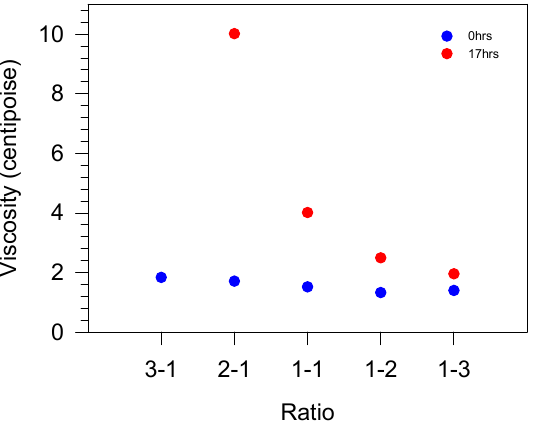
Figure 5. Change in viscosity with increasing TG:ST ratio and crosslinking time. Pot-life was tested for the TGST system to compare with the low-alcohol LA(TGST) system to determine if the removal of alcohols from the TG and ST precursor solutions impacted the LA(TGST) formulation stability with increasing crosslinking time t . All solutions of TGST and LA(TGST) were clear solutions at t = 0 h but became progressively cloudy on standing overnight at t = 17 h and showed full gelation/sedimentation at t = 20 h (Figures S3 and S4 in the Supporting Information). Figure 6a,b shows the formulation sta- bility of the TGST and the LA(TGST) systems at t = 17 h respectively. The solutions with